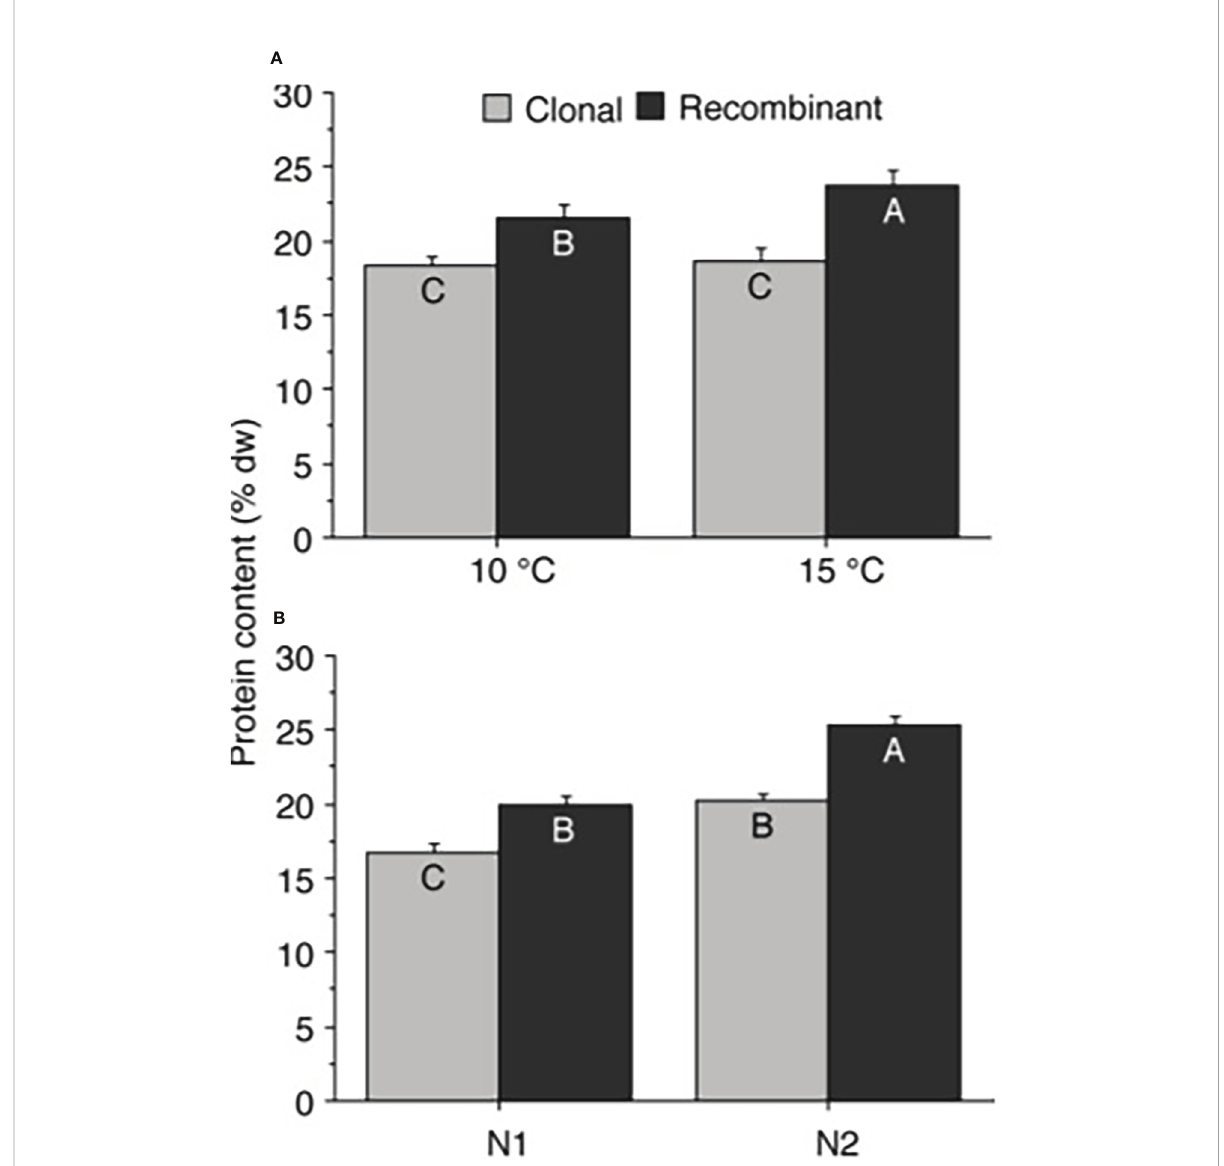
FIGURE 4 Ulva protein content. Protein content (% dw) in Ulva fenestrata clonal and recombinant gametophytes after 12 weeks culture under different (A) temperature (10 and 15°C) and (B) nutrient conditions (N1 = PES, N2 = 3xPES, for further explanations see text). Letters within bars denote signi fi cant differences based on the Student Newman Keul´s (SNK) post hoc test. Treatments with non-overlapping letters are signi fi cantly different (SNK, p < 0.05). Error bars show SEM (n =